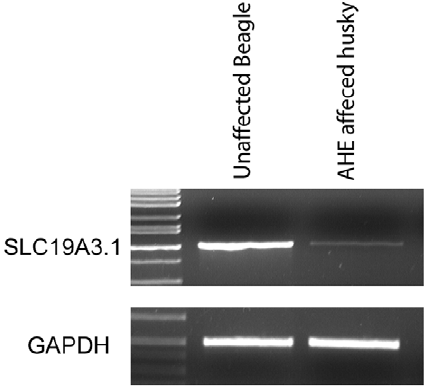
Figure 7. DNA sequence of the mutation identified in AHE. A. wildtype sequence, B. Heterozygous carrier, C. Mutant sequence.